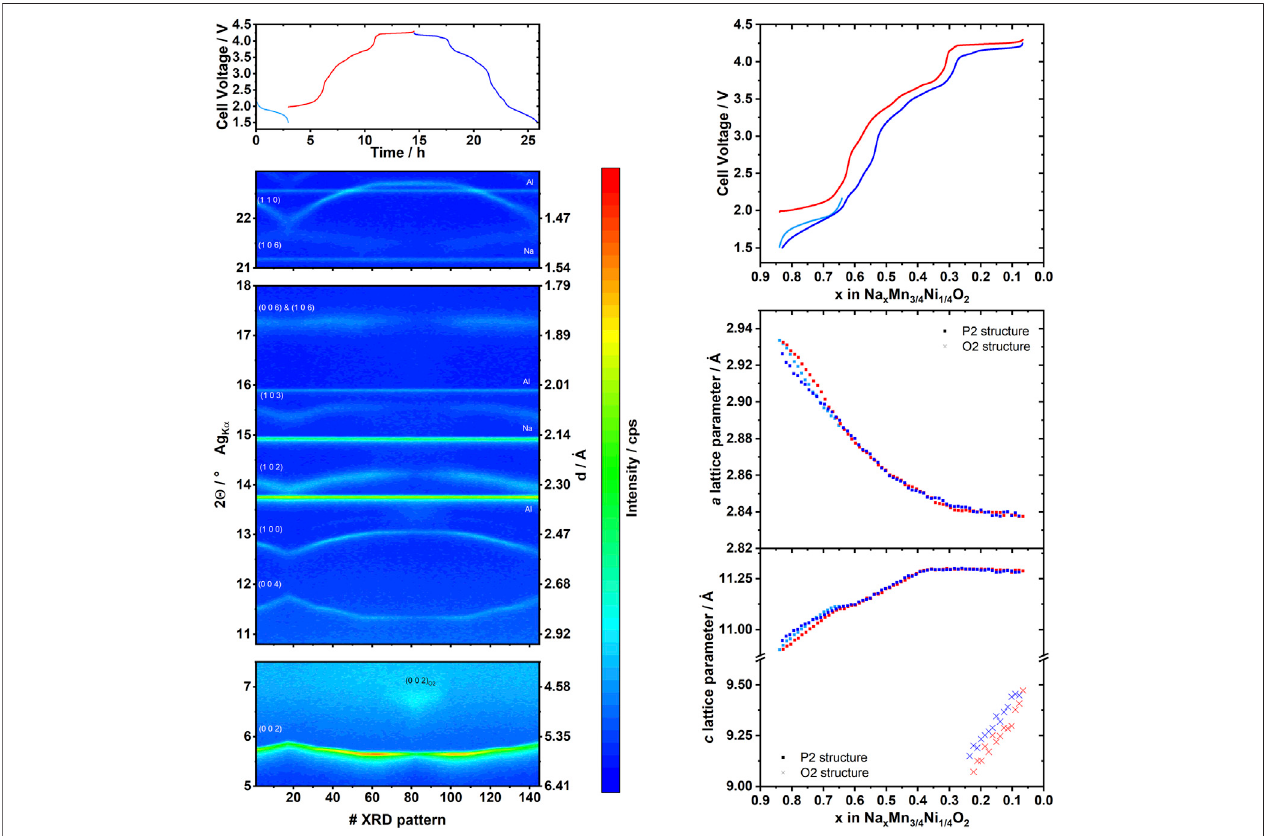
FIGURE 9 | Operando XRD: (left) measured cell voltage during the operando XRD and heat map of the obtained diffraction patterns. (right) cell voltage for the calculated sodium stoichiometry and re fi ned lattice parameters.